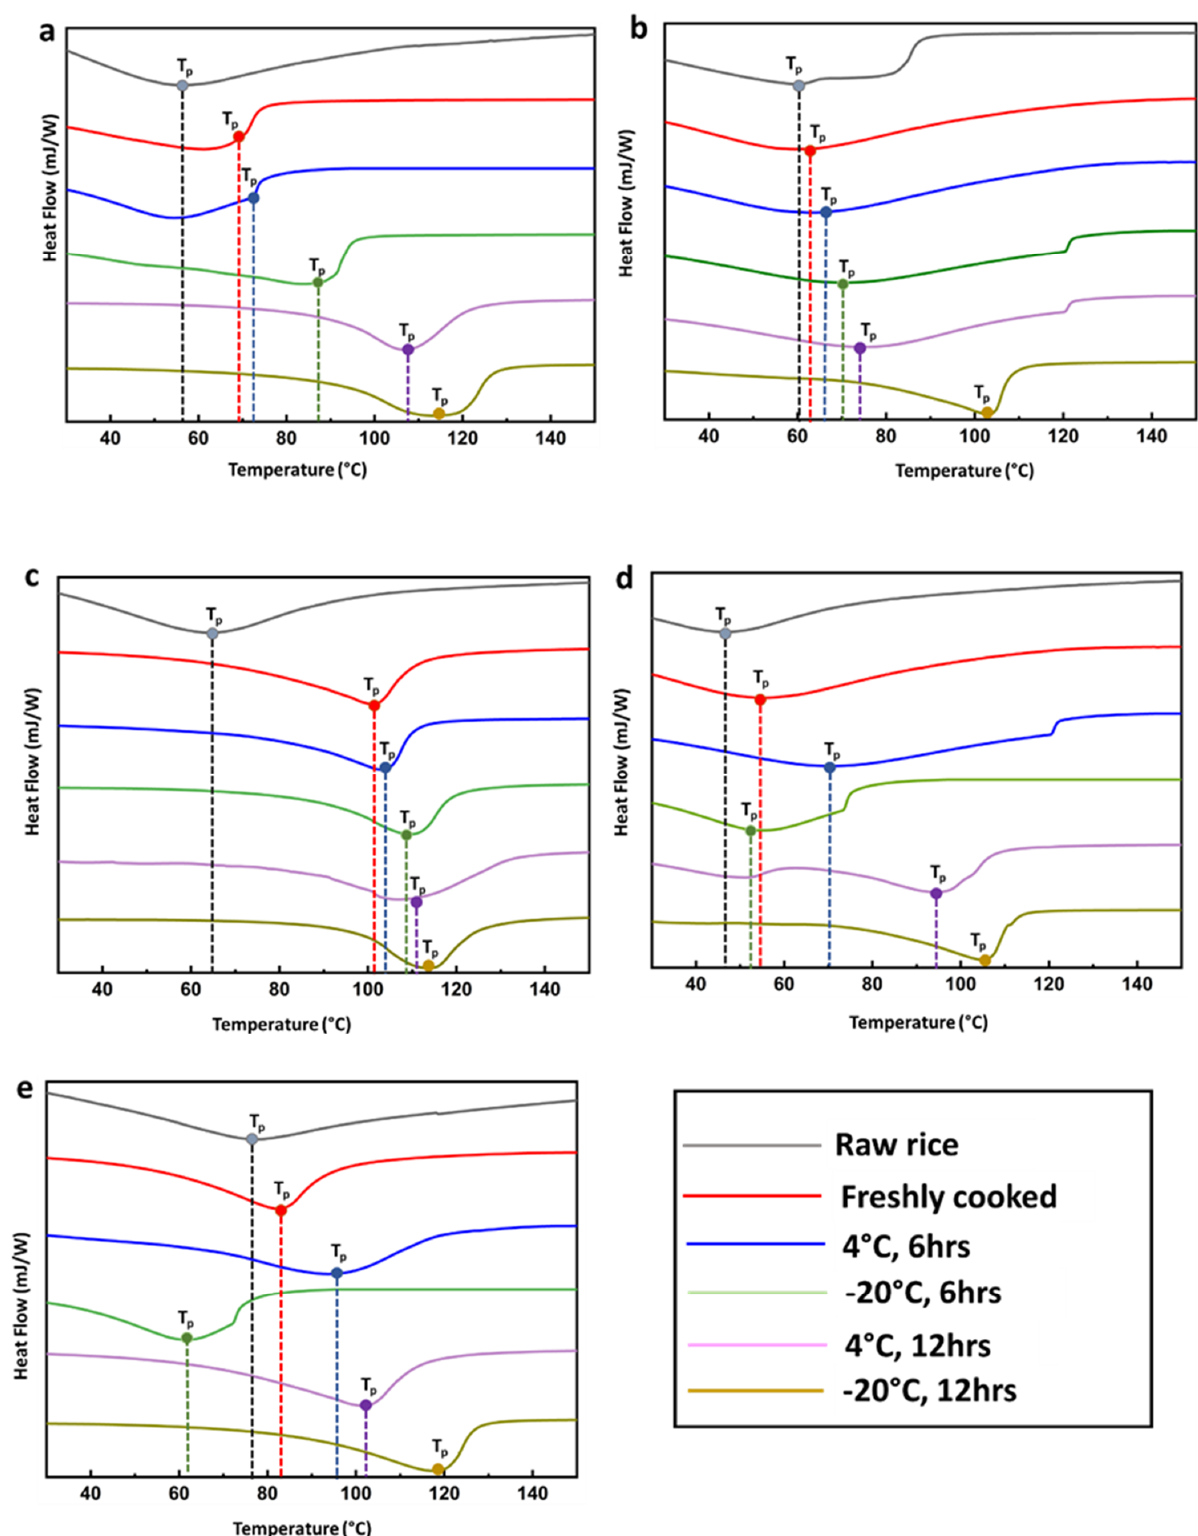
Figure 1. DSC endotherms showing peak gelatinization (T p ) of native starch and retrograded rice samples: ( a ) Diasang lahi, ( b ) Khaju lahi, ( c ) Dhusuri bao, ( d ) Omkar, and ( e ) Bili rajamudi .